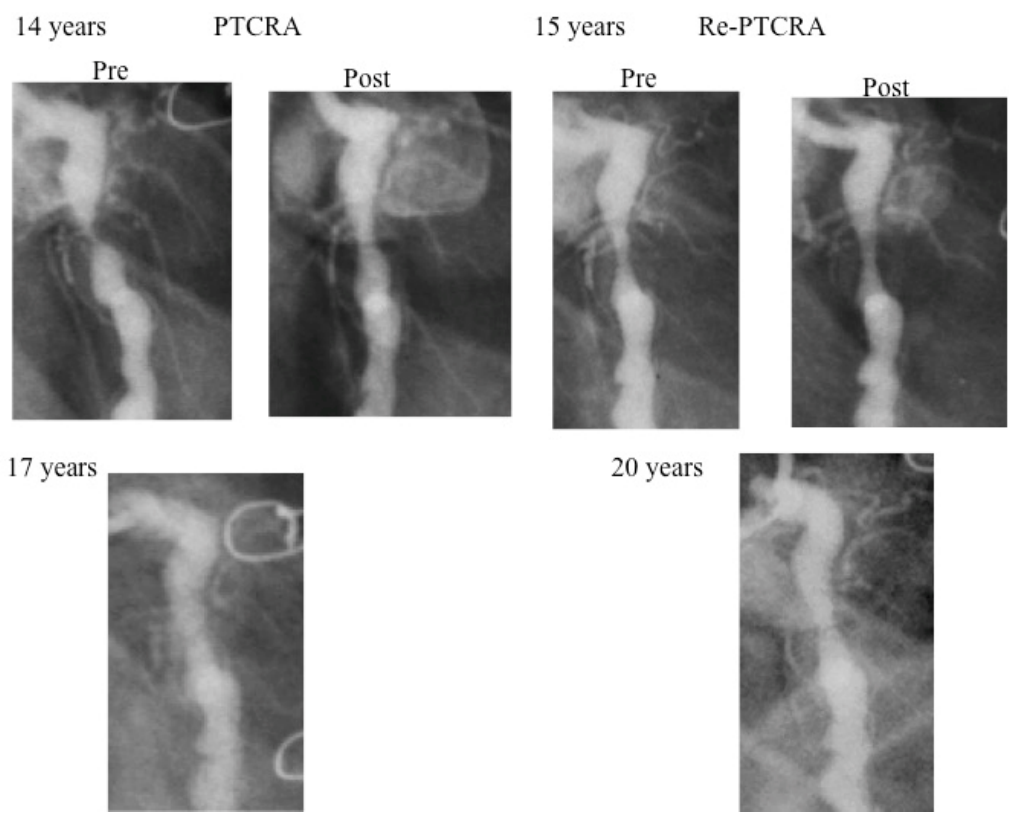
Figure 7. Changes in the degree of stenosis after percutaneous transluminal coronary rotational atherectomy (PTCRA). In a 15-year-old boy, good patency of the left circumflex was maintained after repercutaneous transluminal coronary rotational atherectomy (PTCRA).